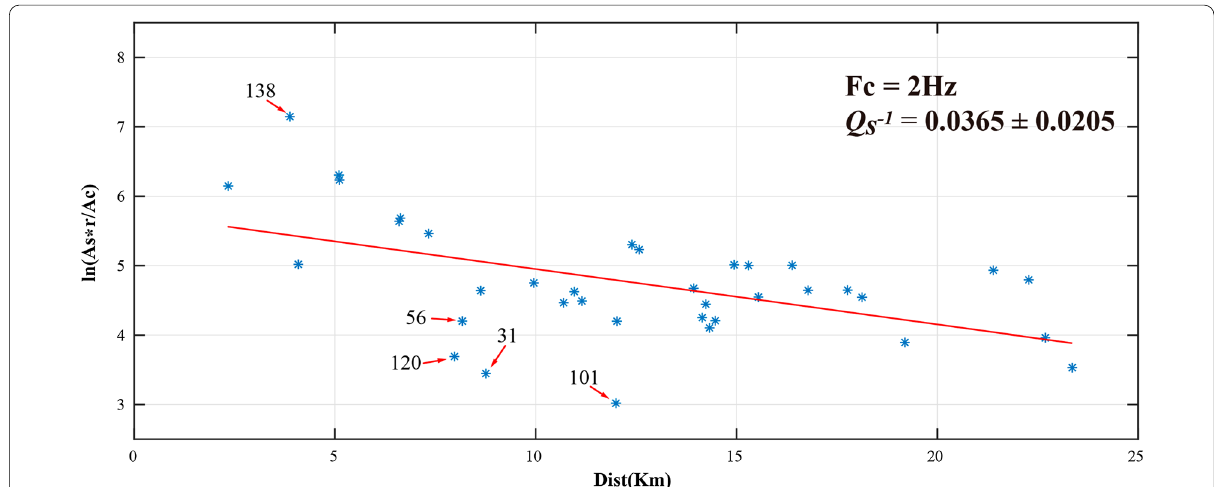
Fig. 11 Schematic diagram of anomalous coda-normalized points